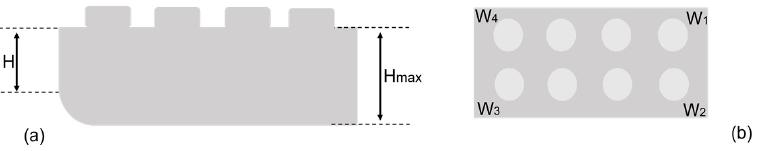
Figure 2. ( a ) Schematic of warping deformation (W = H max -H); ( b ) edges depiction of the 3D object used for measuring warpage. (cid:2892) (cid:3171)(cid:3159)(cid:3182) (cid:2879)(cid:2892) ∗ 100 ) for each edge (W 1 , W 2 , W 3 , W 4 ) of 3D printed Table 3. Warping deformation (%) (cid:4666)W = (cid:2892) (cid:3171)(cid:3159)(cid:3182) object at printing temperatures of 190 and 210°C, respectively. Measurements have been conducted through the auxilium of a caliber.